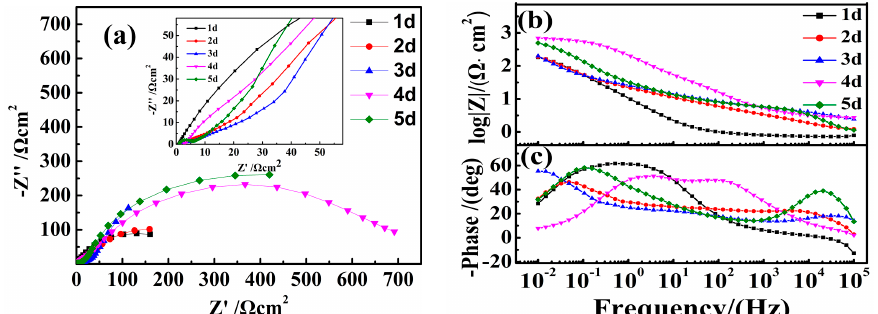
Figure 6. Electrochemical impedance spectroscopy (EIS) spectra results of 12Cr1MoV steel corroded for di ff erent times in the TCSA solution at 55 ◦ C: ( a ) Nyquisy piot, ( b ) Bode plot (log | Z | vs. frequency), ( c ) Bode plot (phase angle vs.